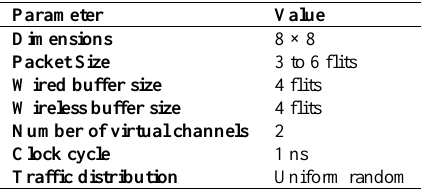
Table 1. Simulation parameters of Noxim.